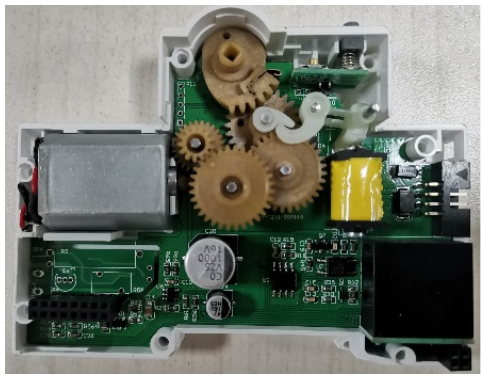
Figure 8. Hardware of operating mechanism and data processing and acquisition. (2) Data acquisition and digital display